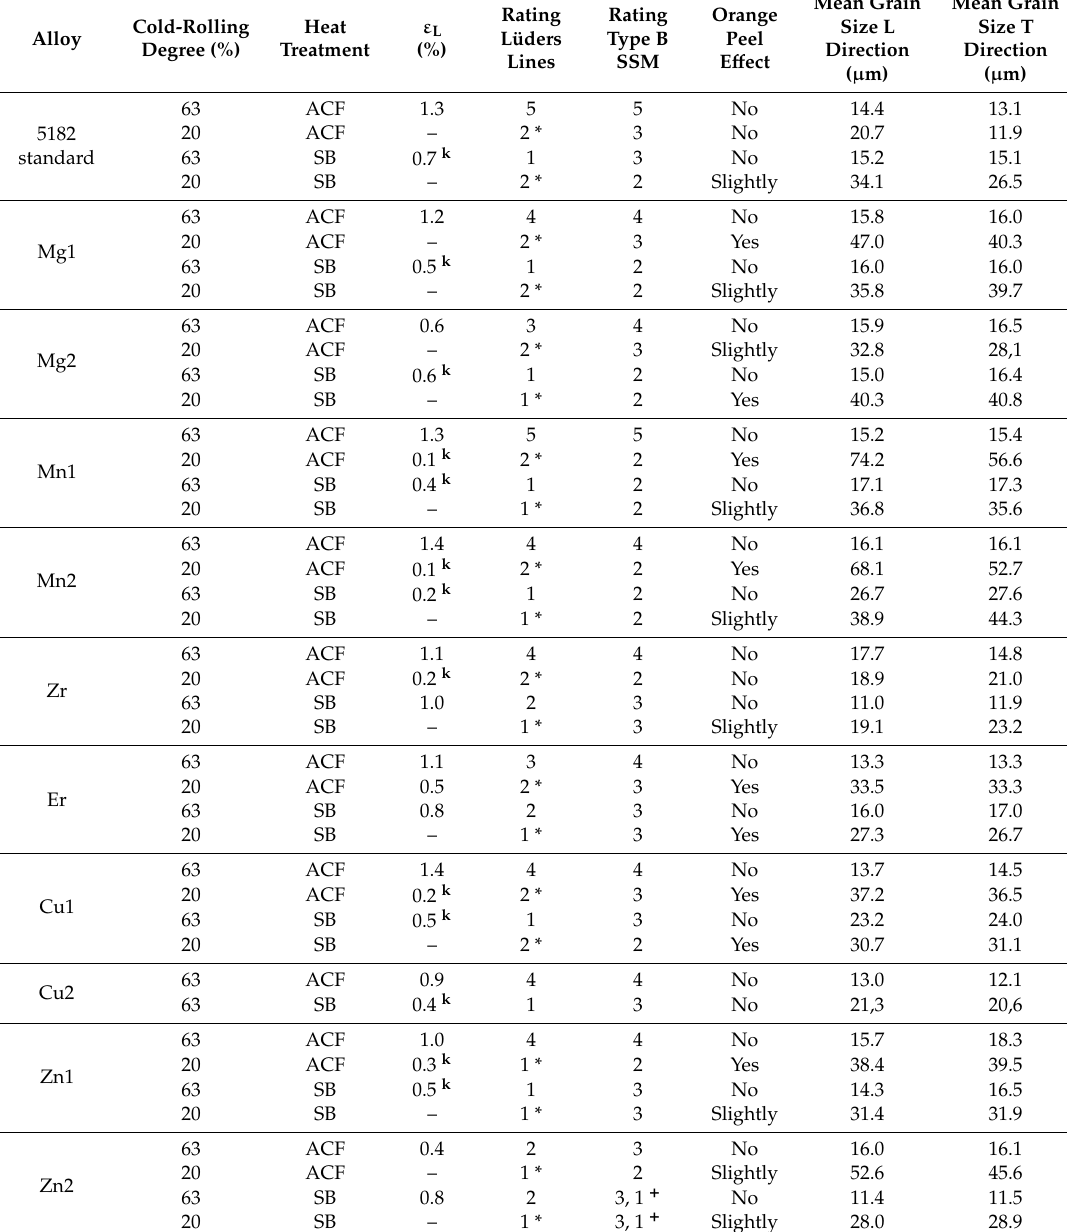
Table 2. Rating of the surface quality of all tested alloy, ranging from 1 (perfect surface) to 5 (worst-case surface quality); ε L —extent of Lüders elongation; indication of orange peel e ff ect; mean grain size in L (longitudinal / parallel to rolling direction) and T (transversal / normal to rolling direction)